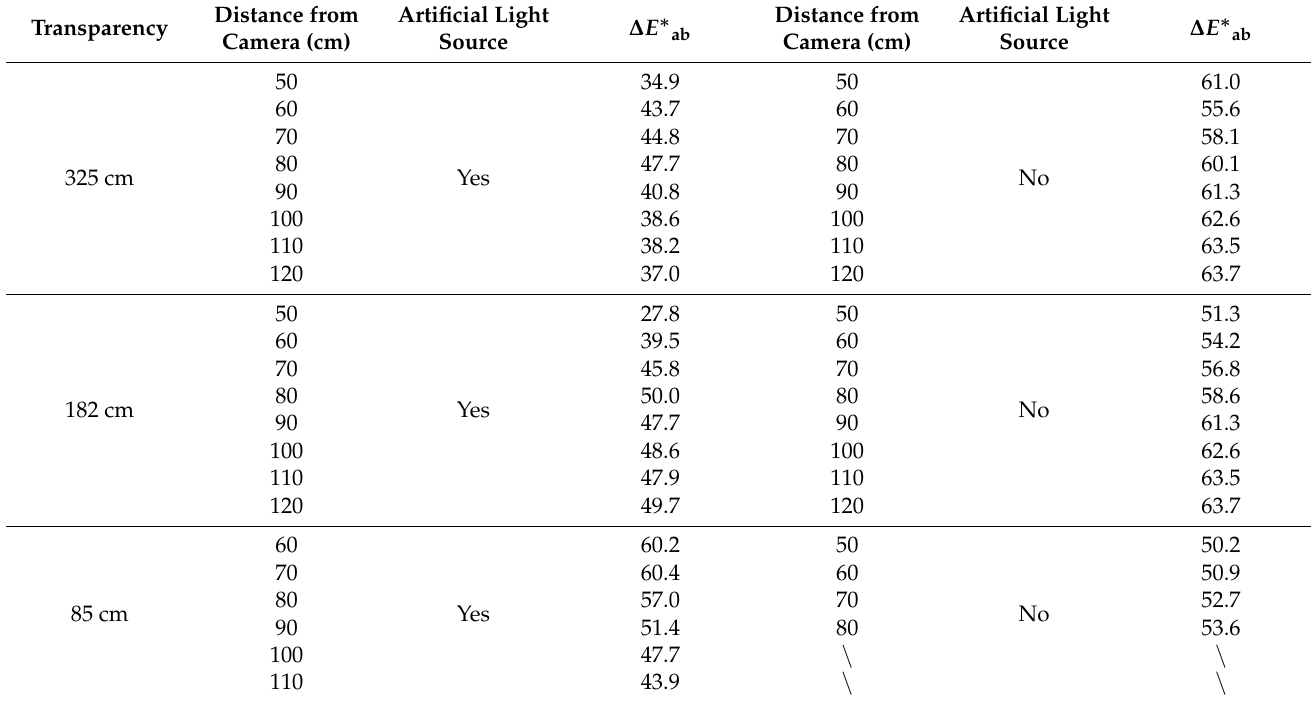
Table 4. Analysis results of ColorCheck module on ColorCheck card.